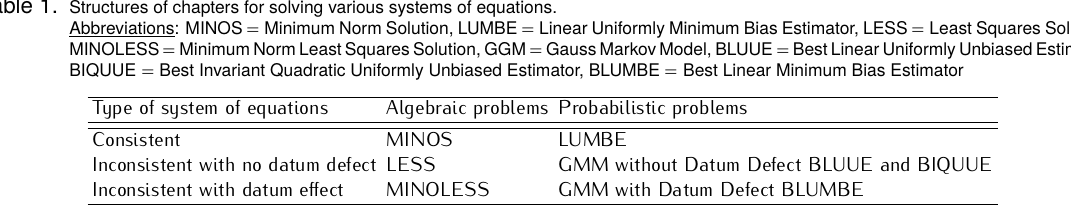
Table 1. Structures of chapters for solving various systems of equations. Abbreviations: MINOS = Minimum Norm Solution, LUMBE = Linear Uniformly Minimum Bias Estimator, LESS = Least Squares